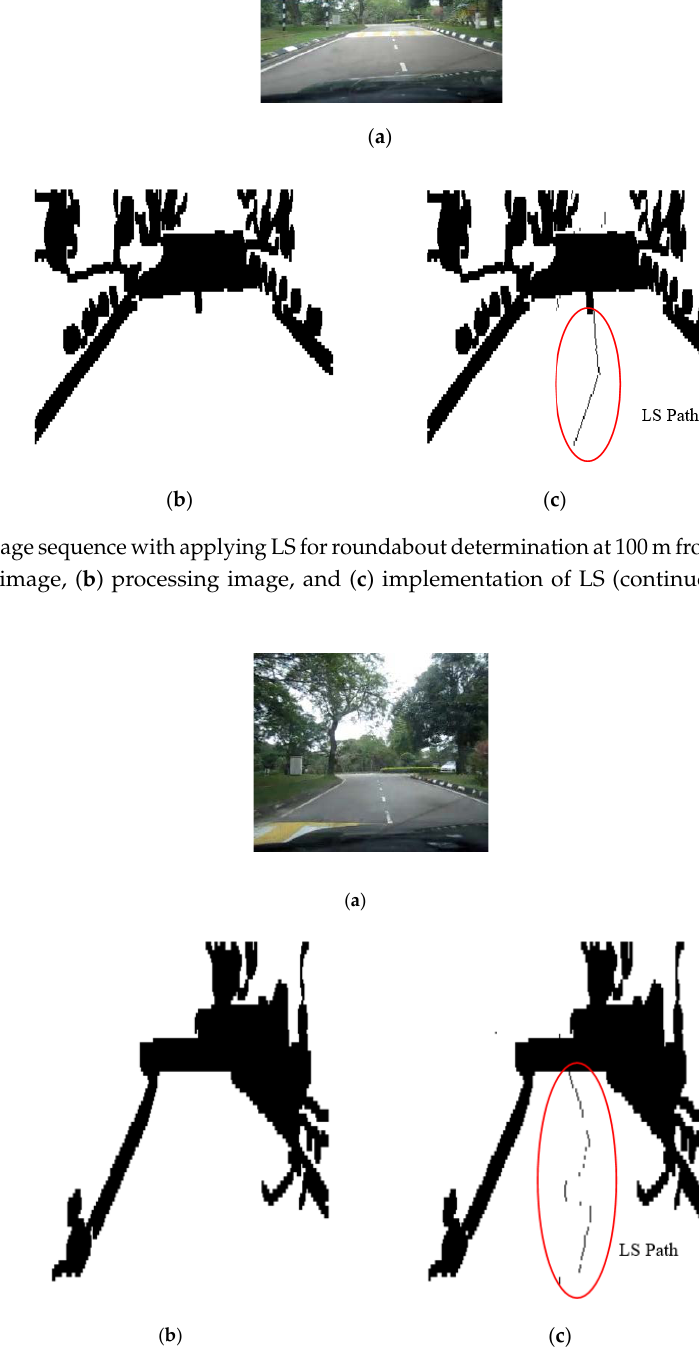
Figure 7. Image sequence with applying LS for roundabout determination at 50 m from the roundabout: ( a ) original image, ( b ) processing image, and ( c ) implementation of LS (continuous dotted line at the middle).